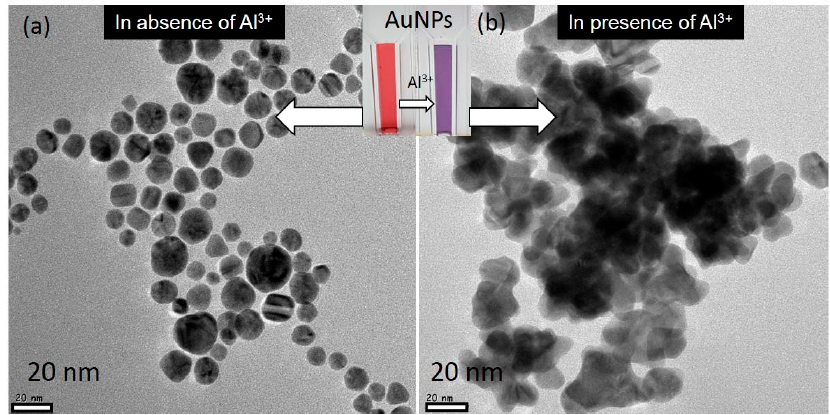
Figure 3. ( a ) The HR-TEM image of AuNPs in absence of Al 3+ ; ( b ) The HR-TEM image of AuNPs in presence of Al 3+ . (Inset showing color of corresponding AuNPs solutions).